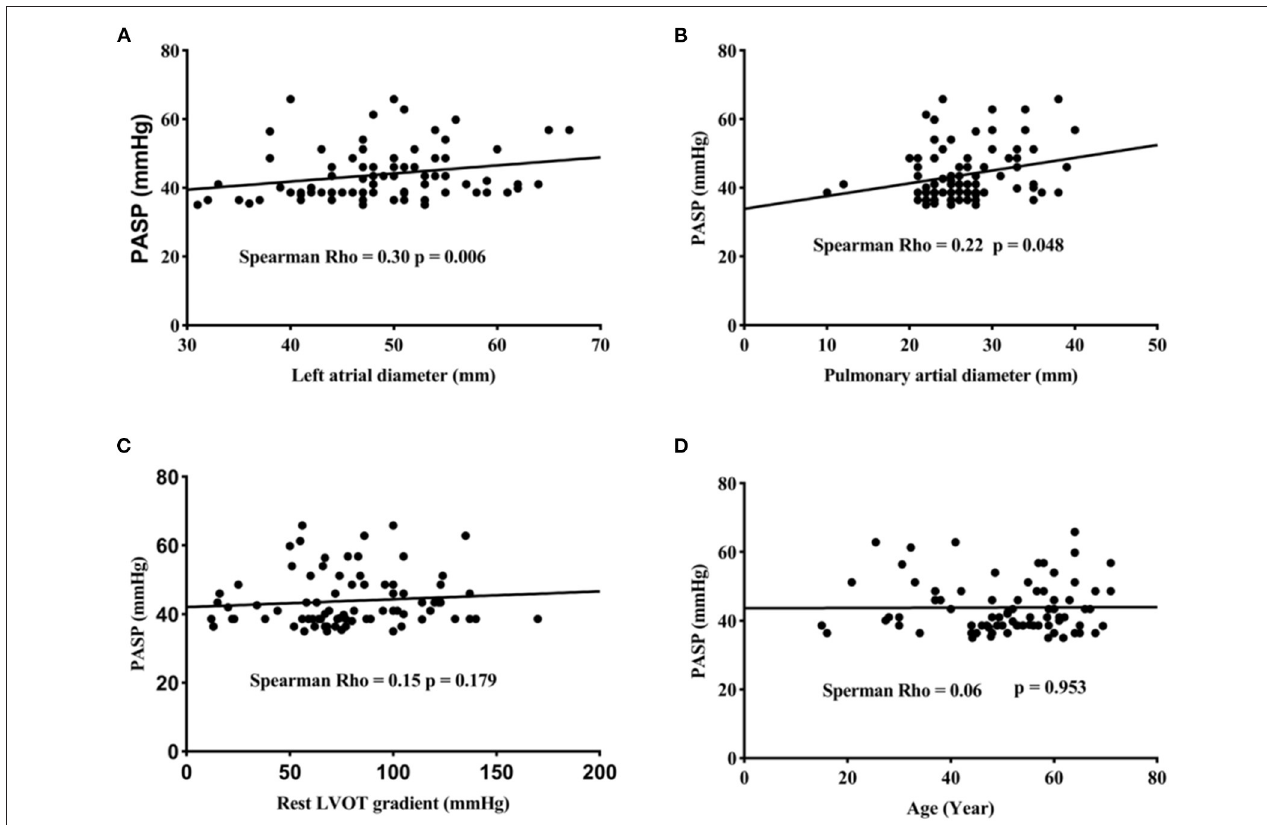
FIGURE 2 | PASP increased with left atrial diameter (A) and Pulmonary arterial diameter (B) . No relationship was found between PASP and the rest left ventricular outflow tract gradient (C) . Pulmonary artery systolic pressure (PASP) is not correlated with age (D) .